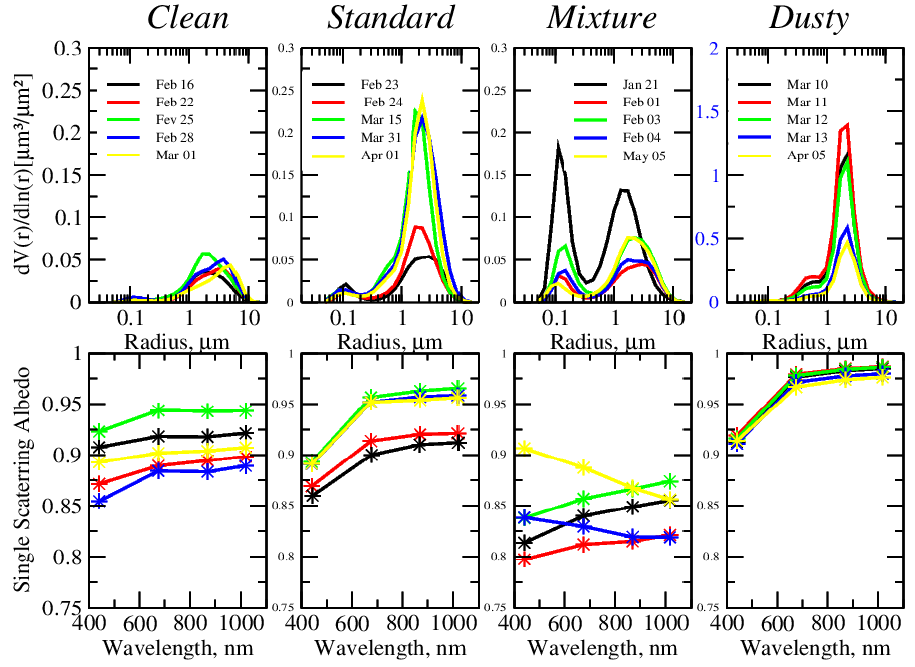
Figure 2. ( top ) Aerosol size distribution and ( bottom ) single scattering albedo retrieved by the AERONET station in Dakar for the five days selected for each day type ( clean , standard , mixture and dusty ). Note that the scale of the vertical distribution is different for dusty days (in